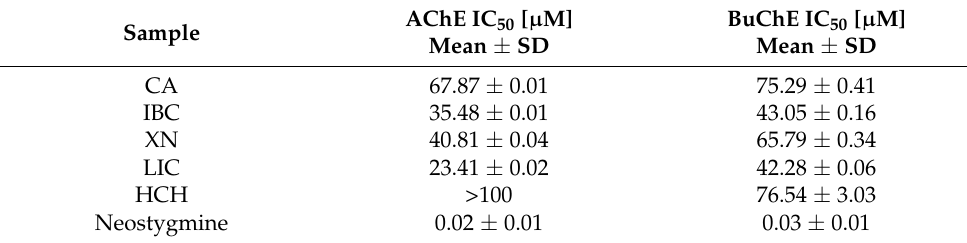
Table 4. In vitro inhibitory concentration of the chalcone compounds against AChE and BuChE (IC 50 µ